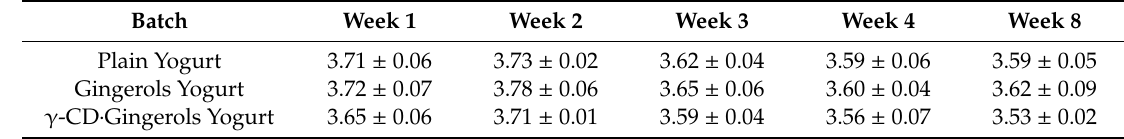
Table 5. Evolution of the pH of the di ff erent yogurt varieties over an observation period of eight weeks.